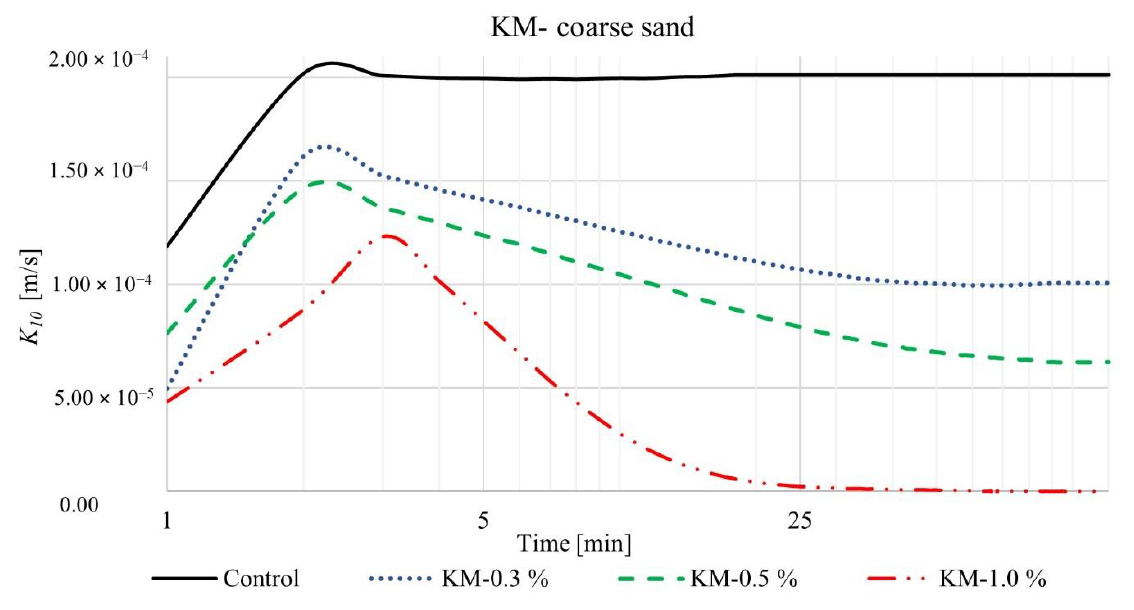
Figure 4. Time-dependent values of coefficient of permeability for SAP-KM and coarse sand mixtures, in proportions of 0.3, 0.5, and 1.0%.